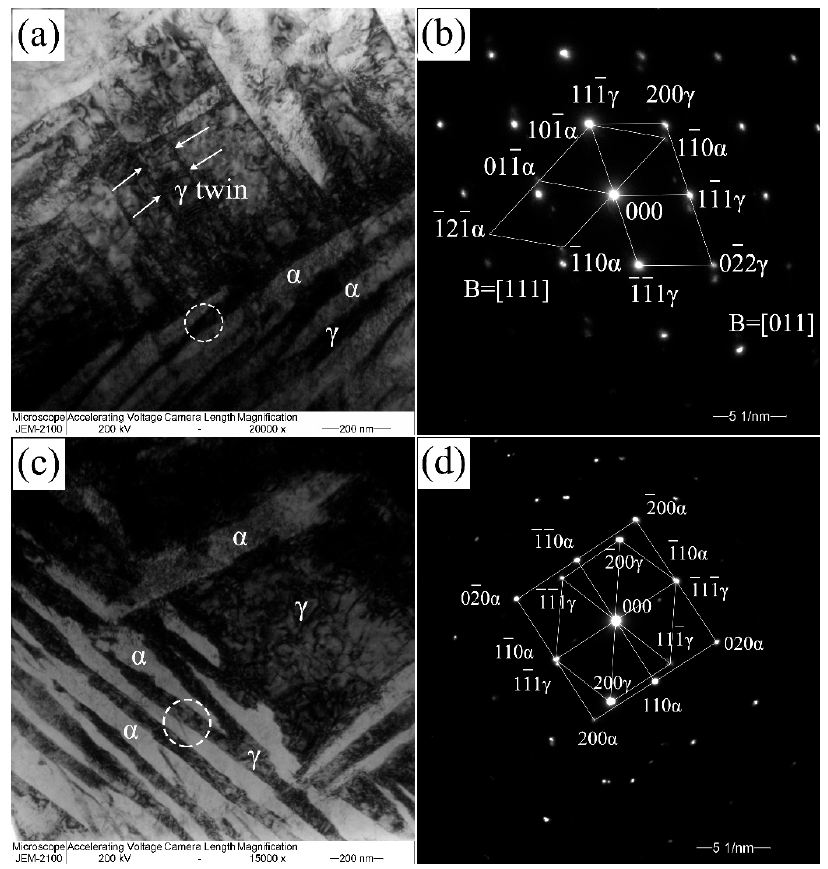
Figure 3. Transmission electron microscopy images of bainitic structure transformed at 200 °C ( a ) and 250 °C ( c ); the corresponding selected areas of electron diffraction (SAED) patterns are ( b , d ).